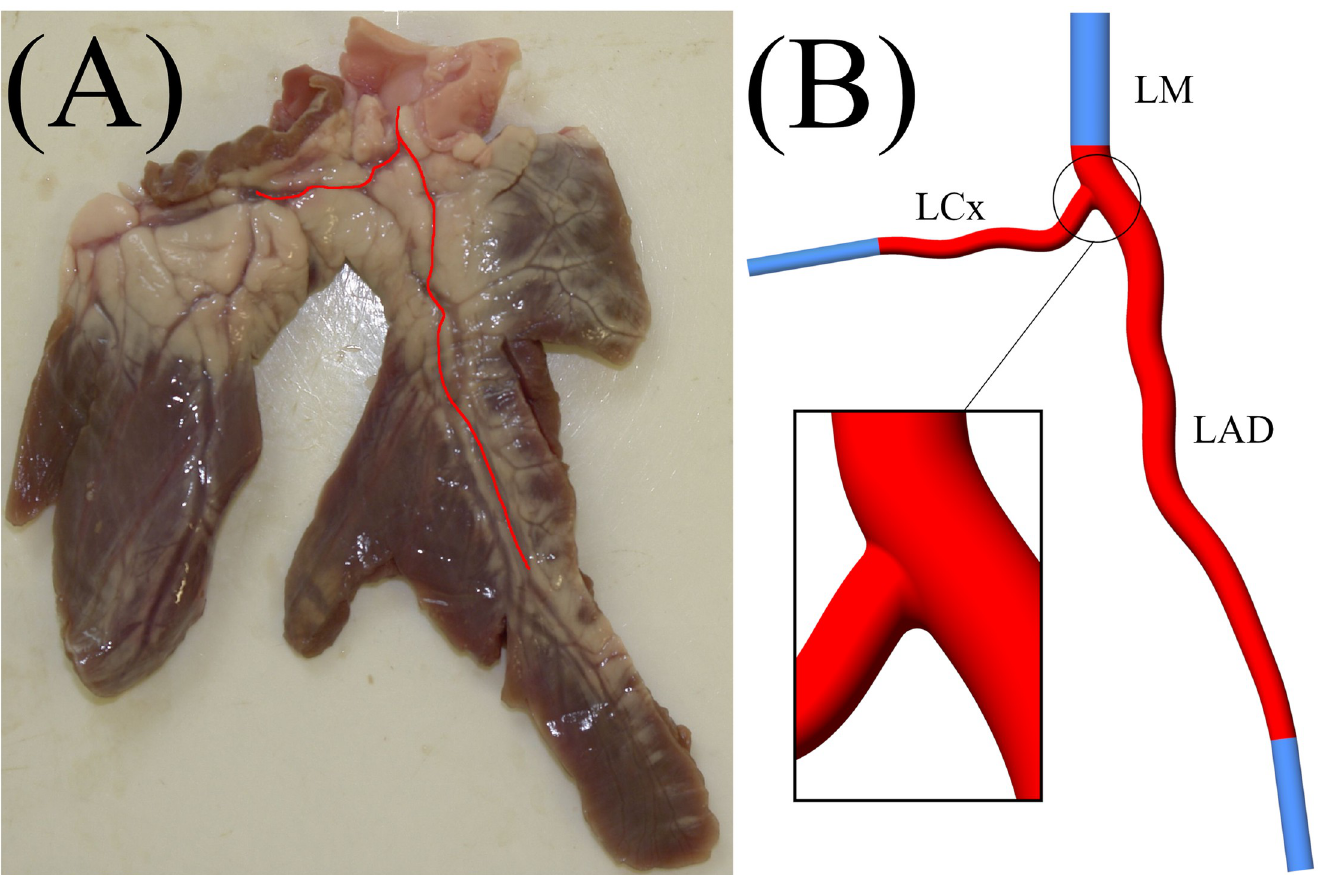
Fig 1. (A)—Porcine ex vivo heart segment, with coronary geometry marked in red. (B) Coronary artery bifurcation geometry including domain extensions shown in blue (LAD, left anterior descending artery; LCx, left circumflex artery; LM, left main coronary artery).